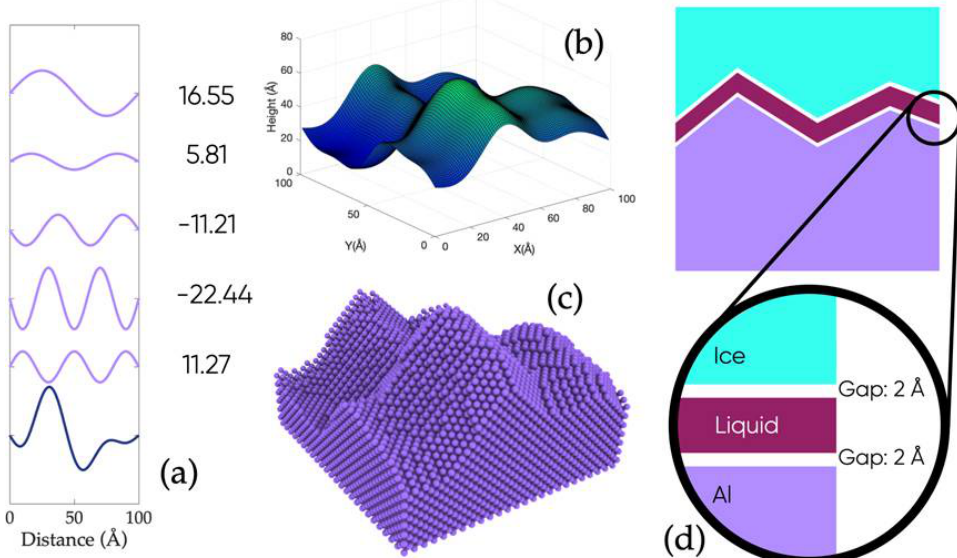
Figure 1. Atomistic systems of ice adhesion on rough surfaces. ( a ) Five sine waves (light purple) with randomly generated amplitudes are added to make a periodic wave (dark blue). ( b ) A random planar wave surface generated by adding sine waves in both x and y directions. ( c ) Rough surface carved by using the periodic planar wave surface in ( b ), with local thickness in the range of 10 to 80 Å. ( d ) Schematic illustration of the atomistic structures of ice adhesion on a rough surface. There is an initial liquid water layer between the ice and the substrate, which can transform into ice or remain amorphous after equilibration simulations depending on the surface.